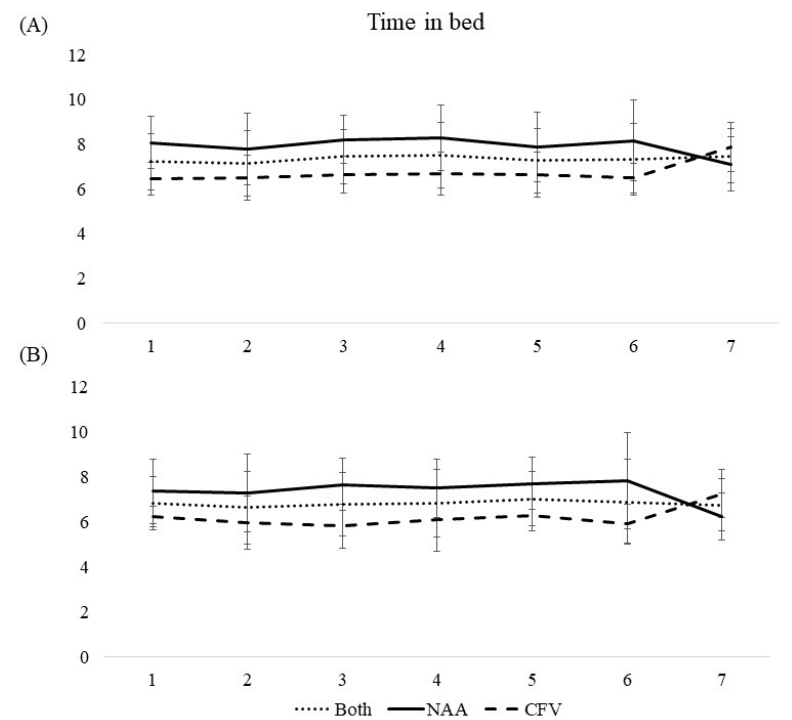
Figure 3. Mean scores of time in bed during a 7-day workweek among pilots in the Norwegian Air Ambulance (NAA; n = 25), Christophorus Flugrettungverein (CFV; n = 22), and both groups collapsed, measured by ( A ) sleep diary and ( B ) actigraphy. Error bars represent standard deviations.